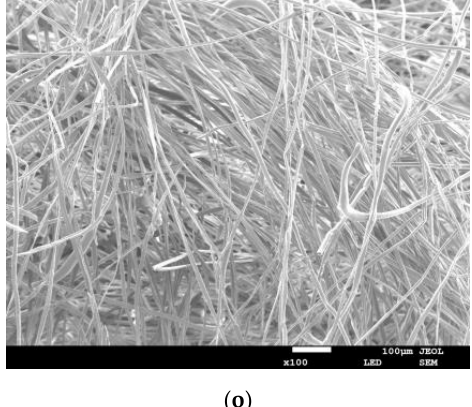
Figure 5. Scanning electron microscope (SEM) images of composite materials with different mass fractions, volume densities and thicknesses: ( a ) The mass fraction of poplar seed fiber is 25% ( b ) The mass fraction of poplar seed fiber is 35% ( c ) The mass fraction of poplar seed fiber is 45% ( d ) The mass fraction of poplar seed fiber is 55% ( e ) The mass fraction of poplar seed fiber is 65% ( f ) The material density is 0.076 g/cm 3 ( g ) The material density is 0.102 g/cm 3 (h) The material density is 0.172 g/cm 3 ( i ) The material density is 0.153 g/cm 3 ( g ) The material density is 0.178 g/cm 3 ( k ) The Material thickness